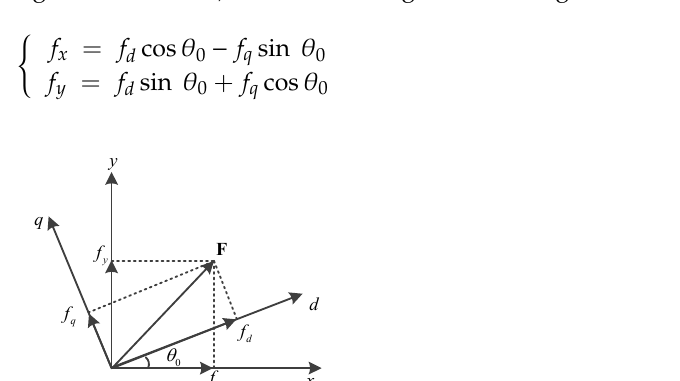
Figure 4. Transformation relations of a variable’s dq ‐ components between the global frame and the local frame [15].